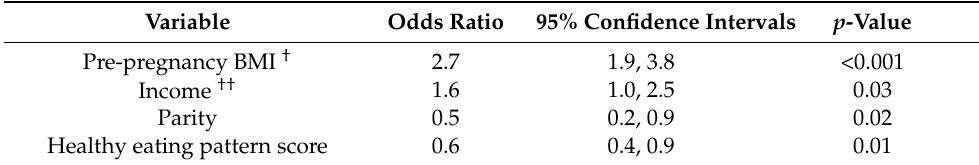
Table 4. Associations with the development of gestational